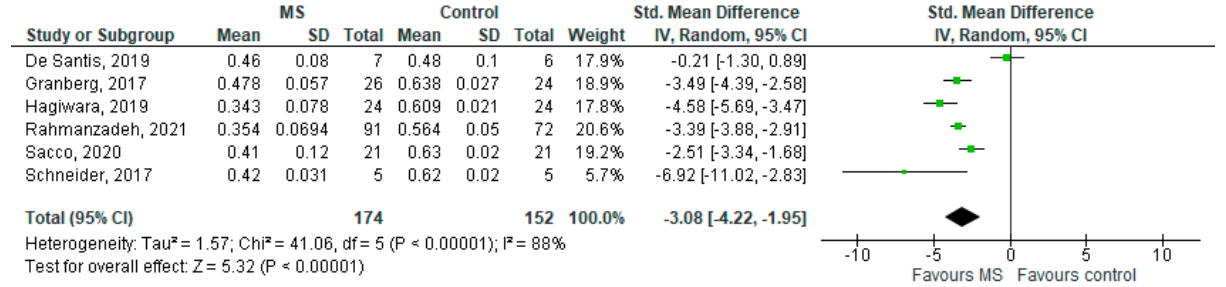
Figure 2. Forest plot for the standardised mean difference of the NDI in MS WM lesions (MS vs. control) [20,23–26,29]. Abbreviations: SD = standard deviation; CI = confidence interval; NDI = Neurite Density Index; MS = multiple sclerosis; WM = white mater; vs. = versus; and I2 = Heterogeneity Index.